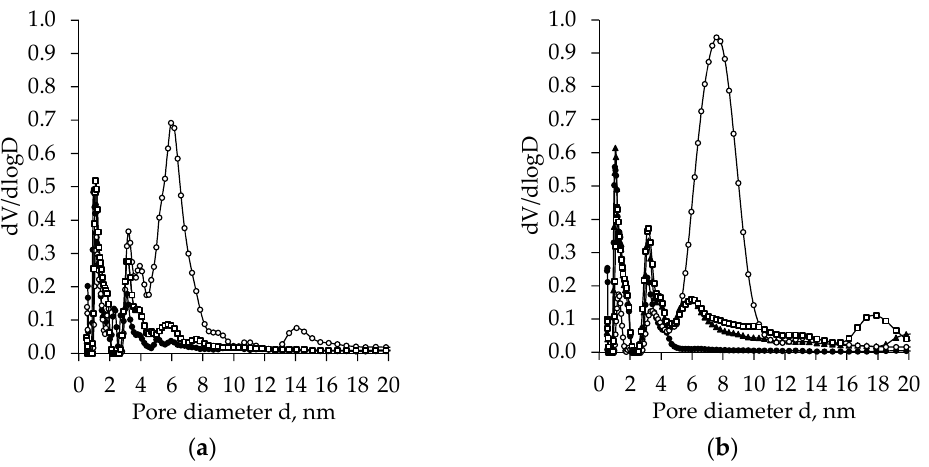
Figure 7. Pore size distribution of subcritical dried unaged ( a ) and aged ( b ) TiO 2 aerogel synthesized using the precursor TIP and additional solvent exchange ( –without exchange, –nH, ▲ – cH, –DE).